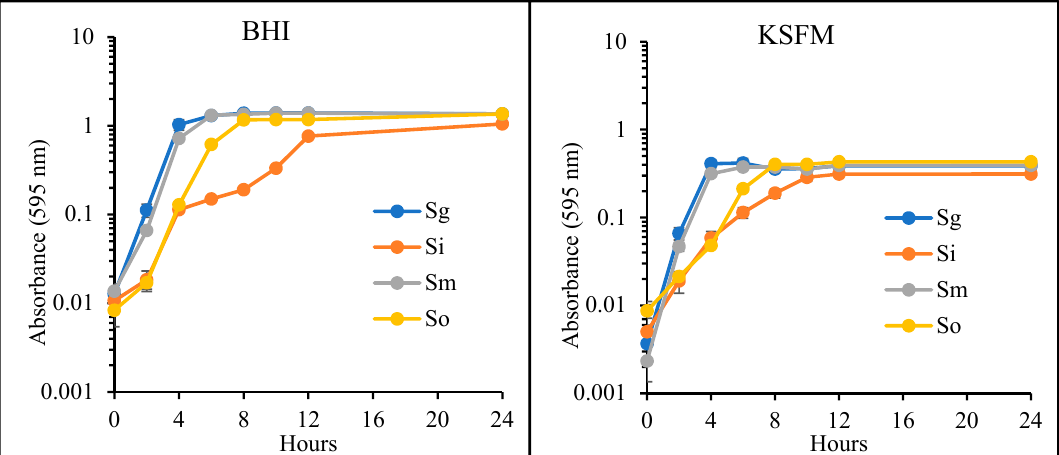
Figure 1. Growth of commensal bacteria in Brain Heart Infusion Broth (BHI) and Keratinocyte Serum-Free Growth Medium (KSFM). S. gordonii (Sg), S. intermedius (Si), S. mitis (Sm) and S. oralis (So) were grown in KSFM and BHI. Absorbance was measured at indicated time-points ( n = 3).